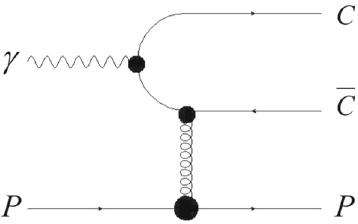
Fig. 1 The schematic diagram of the photon–gluon fusion model